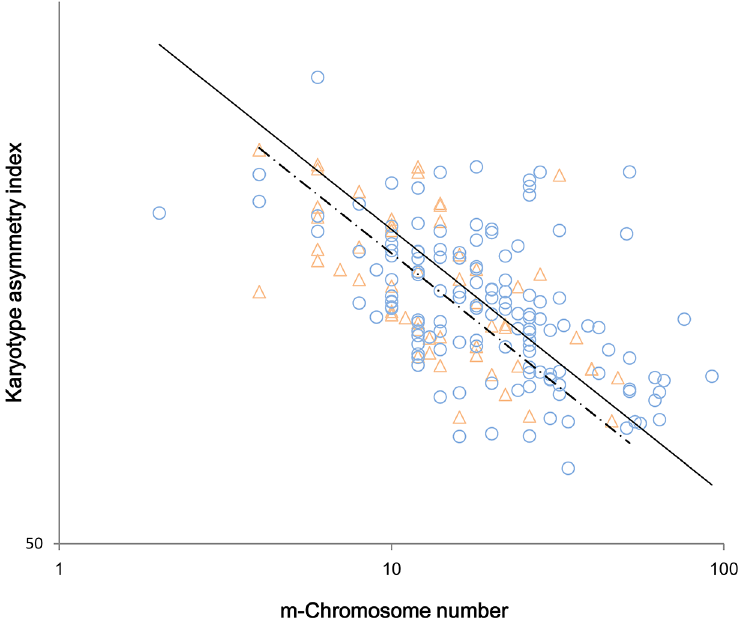
Fig 2. Cross-species scaling relationship of karyotype asymmetry vs. m-chromosome number among deciduous species (D-group) and evergreen species (E-group). There are two regression lines of the reduced major axis (RMA) in the graph for the D-group (triangles and the solid line) and for the E-group (circles and the dashed line), respectively.